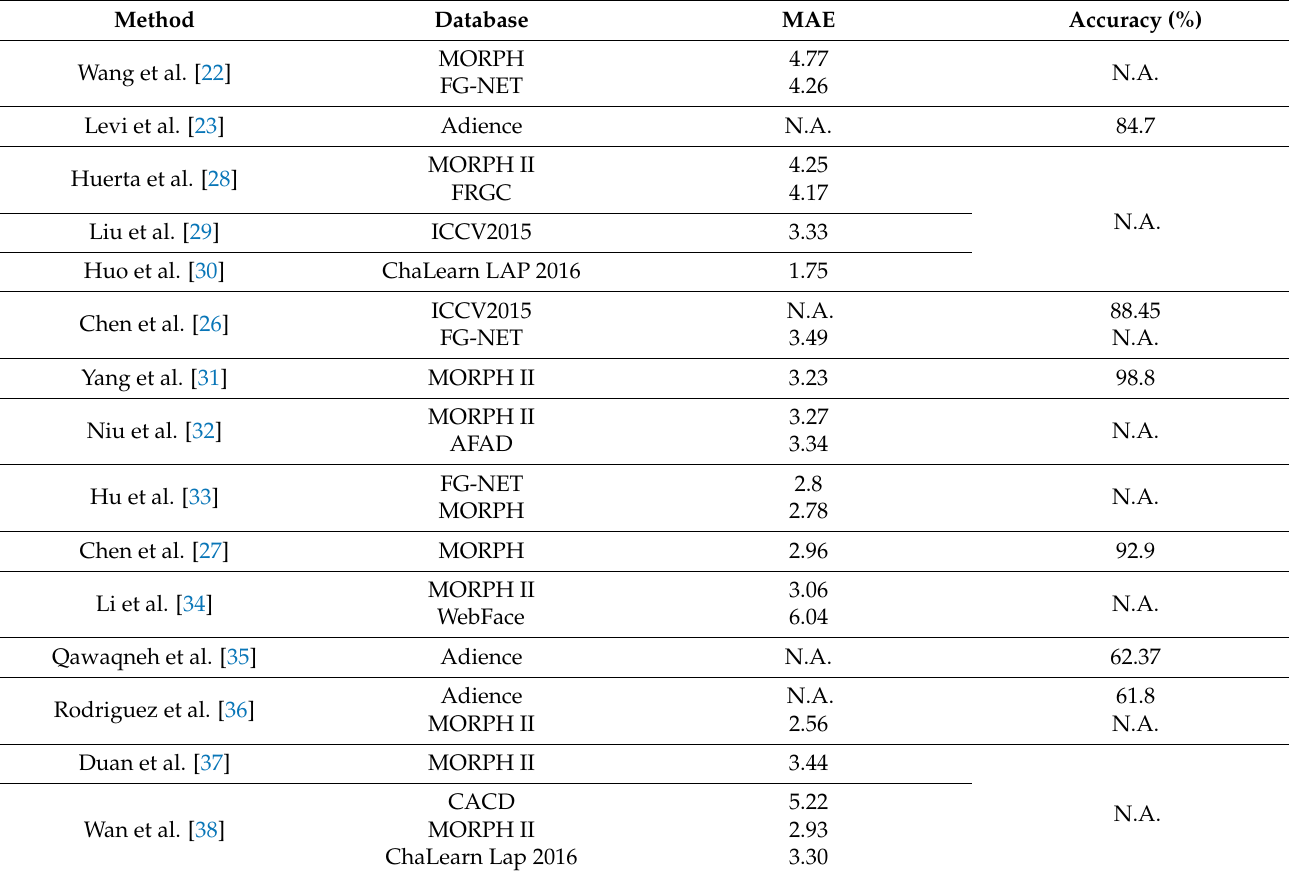
Table 1. Comparison of previous research on age estimation using deep learning (N.A. means “not available”).